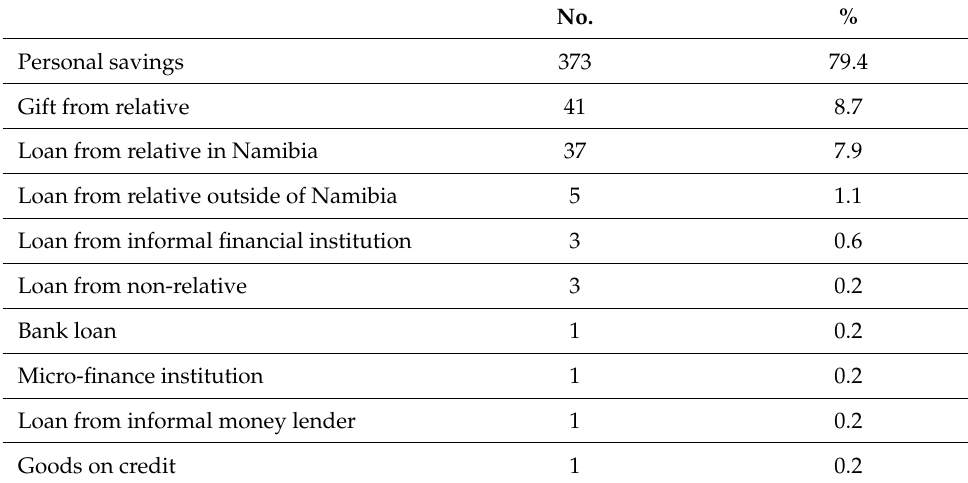
Table 7. Sources of financing of informal food enterprises in Windhoek, Namibia.